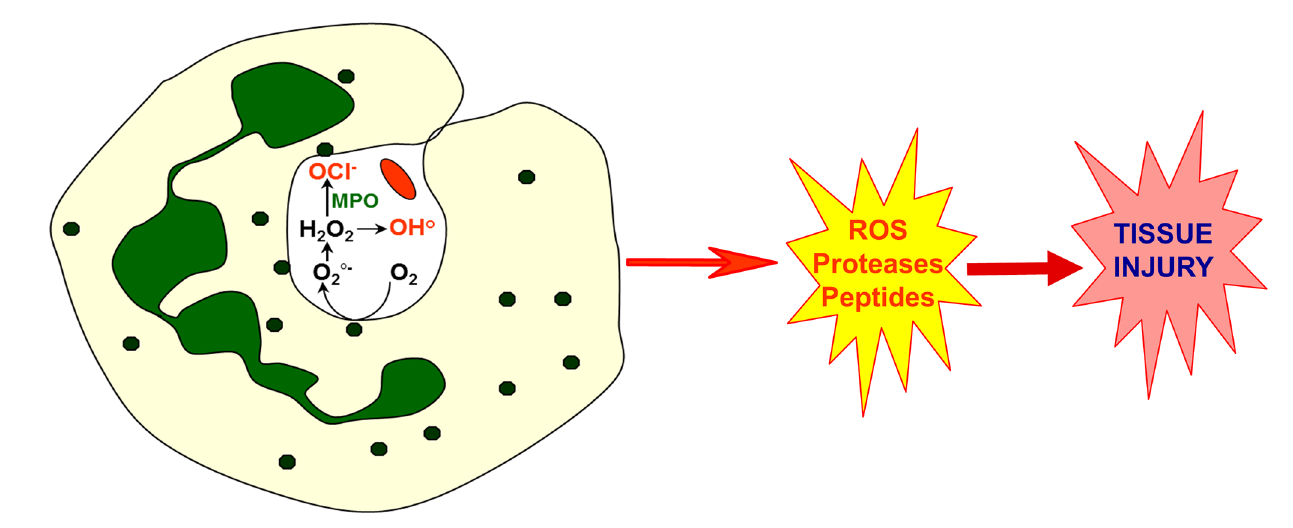
Figure 2. Activation of neutrophils. At the inflammatory site, neutrophils engulf the invading agent. Phagocytosis, in turn, induces a physiologically controlled activation of neutrophils, leading to the release of ROS and proteins inside the phagosome. However, excessive activation of neutrophils results in excessive release of ROS and granule contents in the extracellular space, contributing to tissue damage and